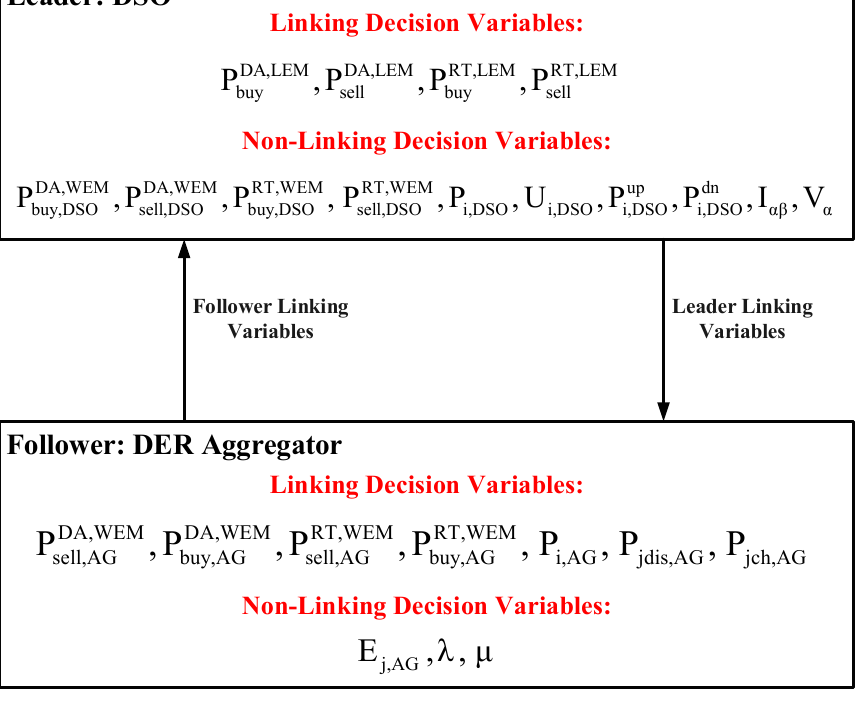
Figure 3. Decision variables of entities in the suggested leader–follower decision-making model.